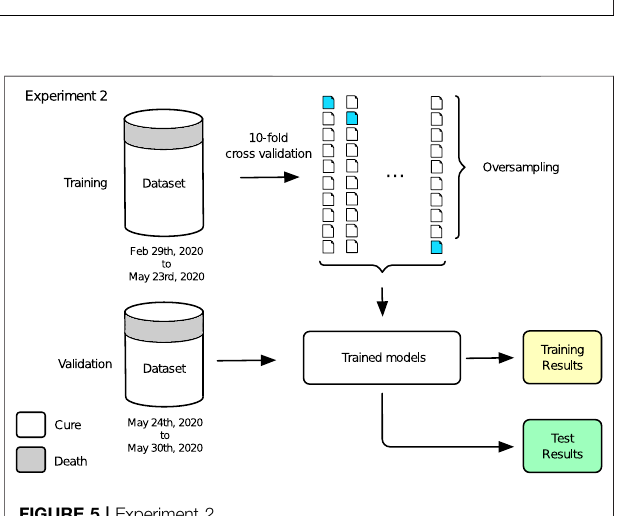
FIGURE 5 | Experiment